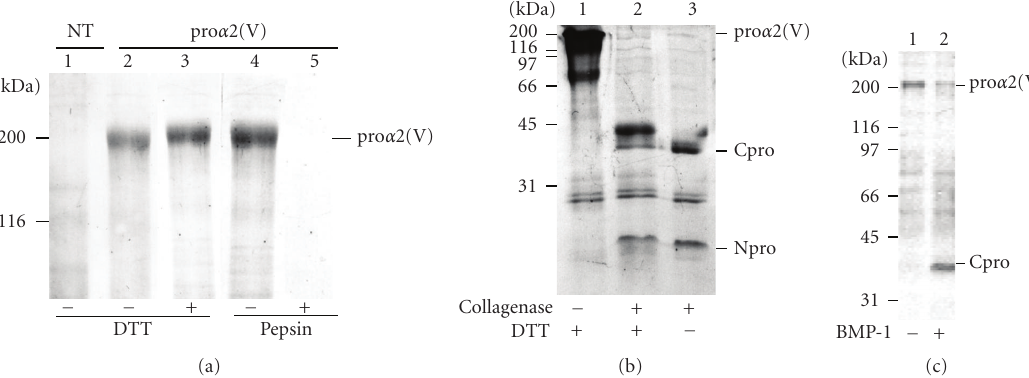
Figure 2: Biochemical analysis of the recombinant pro α 2(V) chains produced in HEK-293 cells. (a) 6% SDS-PAGE analysis of cell media from untransfected cells (lane 1) and from cells transfected with human pro α 2(V) construct (lanes 2–5) under unreduced (lanes 1, 2) or reduced (lanes 3, 4, 5) conditions. Transfected cells media were incubated without (lane 4) or with (lane 5) pepsin before SDS-PAGE analysis. (b) Digestion with bacterial collagenase: transfected cell media were incubated without (lane 1) or with (lanes 2, 3) collagenase before 12% SDS-PAGE analysis under reduced (lanes 1, 2) or unreduced (lane 3) conditions. (c) Digestion with BMP-1: 12% SDS-PAGE patterns of transfected cells media digested (lane 2) or not (lane 1) with BMP-1. Gels (a) and (b) were stained with Coomassie blue whereas gel (c) was silver stained. Left, molecular mass standards expressed in kDa. NT : not transfected, pro α 2(V): transfected with pro α 2(V) construct, DTT : dithiothreitol, Cpro : C-propeptide, Npro : N-propeptide, BMP-1 : Bone Morphogenetic Protein 1.